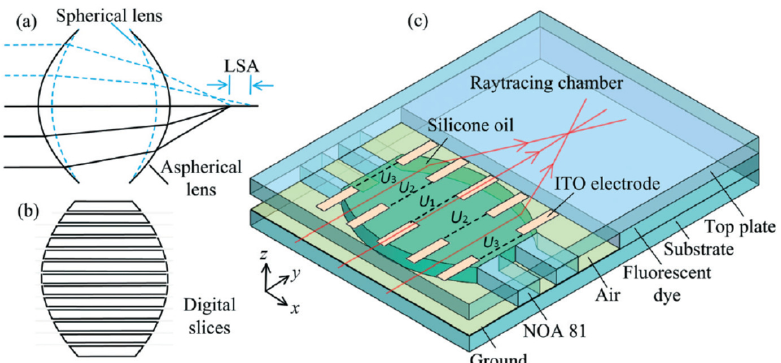
Figure 26. Schematic design of the DEP-actuated aspherical lens with two arrays of ITO electrode strips patterned on the top plate. ( a ) Working principle of the control of longitudinal spherical aberration (LSA). ( b ) The lens interfaces are divided into discrete slices with variable local curvatures to form an aspherical lens. ( c ) Schematic design of the DEP-actuated aspherical lens [131]. Reprinted with permission from Ref. [131]. 2020 Royal Society of Chemistry.